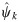
Quantifying the global symmetry of firing patterns.a) Generated spike maps in a 1m × 1m arena. Each spike k is color-coded with its grid score ψ^k; global Ψ score shown above. Top: Perfect grid. Middle: Weakly perturbed grid field locations. Bottom: Strong perturbations. See text for description of perturbations. b) Autocorrelograms of the spike maps shown in a; ρ score shown above. c) Decay of Ψ score (top) and ρ score (bottom) with increasing noise on grid field locations. Box plot for 100 random realizations at each noise level. For details on the box plot see S1 Appendix. Noise values for the examples shown in a are indicated with markers. d) Correlation of Ψ score with ρ score and Pearson’s coefficient r for the generated data used in a, b, c. e) Same as d but with experimentally recorded data from [6, 16].